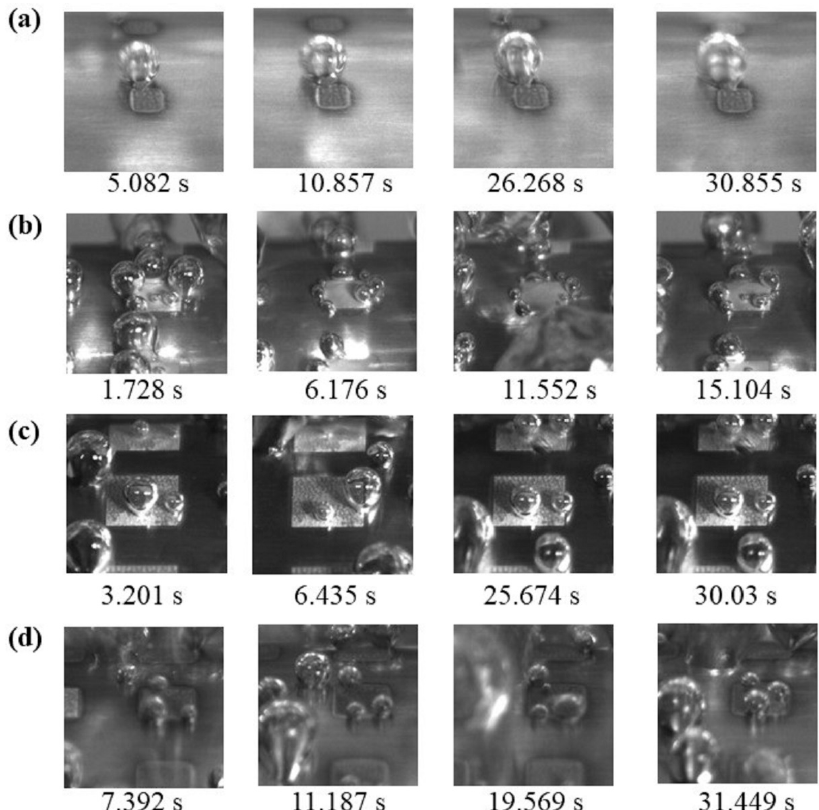
Figure 6. Comparison of the number of active nucleation sites for the surfaces with ( a ) 0.2 aspect ratio; ( b ) 0.4 aspect ratio; ( c ) 0.6 aspect ratio; and ( d ) 0.44 aspect ratio, at a constant input power of 30 W.